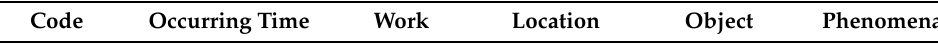
Table 1. Total defect index list of